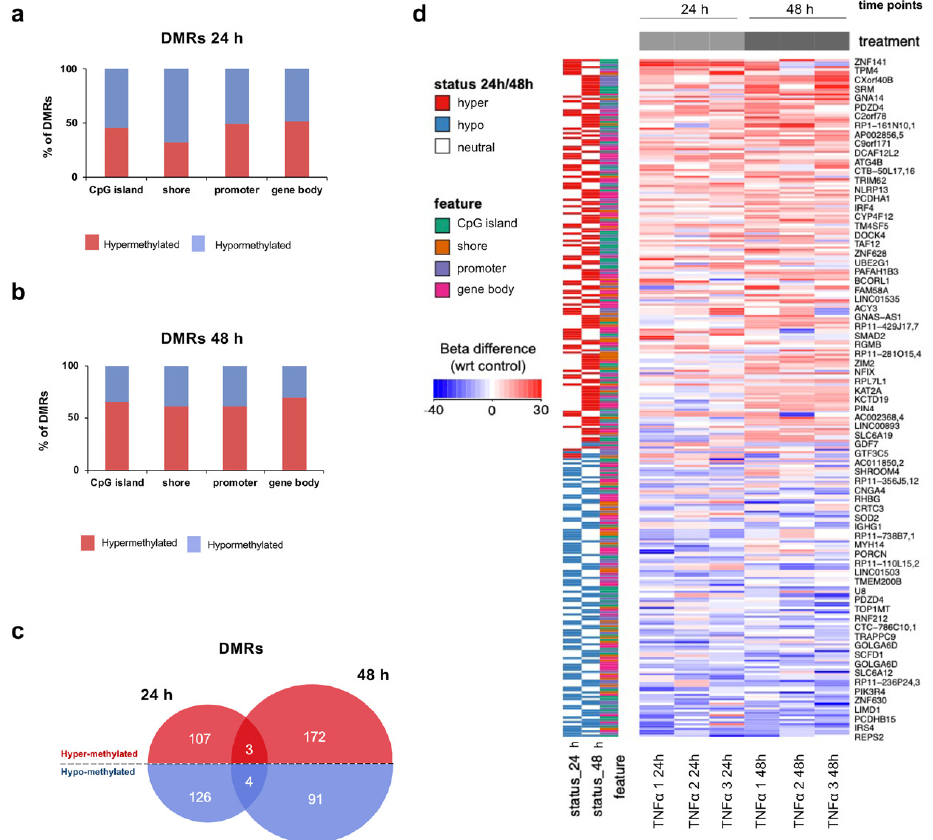
Figure 5. Characteristics of regions di ff erentially methylated by TNF α treatment. ( a , b ) Percentage of hyper-methylation (red) and hypo-methylation (blue) of significant di ff erentially methylated genomic elements (CpG island, shore, promoter, gene body) at ( a ) 24 h and ( b ) 48 h of TNF α stimulation in comparison to untreated samples. Data are expressed as percentage of total number of significant di ff erentially methylated regions (DMRs; FDR < 0.05 logistic regression corrected for multiple comparisons using Benjamini-Hochberg, methylation di ff erence ≥ 10%). ( c ) Venn diagram reporting the number of hyper- and hypo-methylated significant DMRs (FDR < 0.05 logistic regression corrected for multiple comparisons using Benjamini-Hochberg, methylation di ff erence ≥ 10%) detected at 24- and 48- hour time-points. ( d ) Heat map showing the di ff erence of methylation level of TNF α -treated hfNBMs with respect to untreated cells at 24- and 48- hour time-points. Shown are 24 h and 48 h DMRs evaluated at CpG islands (green), shores (orange), promoters (purple) and gene bodies (pink) and detectable in both time points.